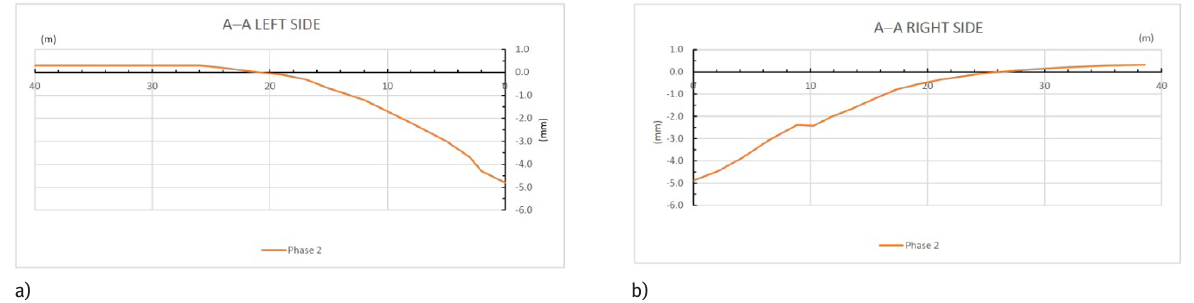
Figure 6: Phase 2 of the implementation – erecting slurry walls; graph of vertical displacements of the land surface in the A–A cross section: a) on the left, b) on the right.